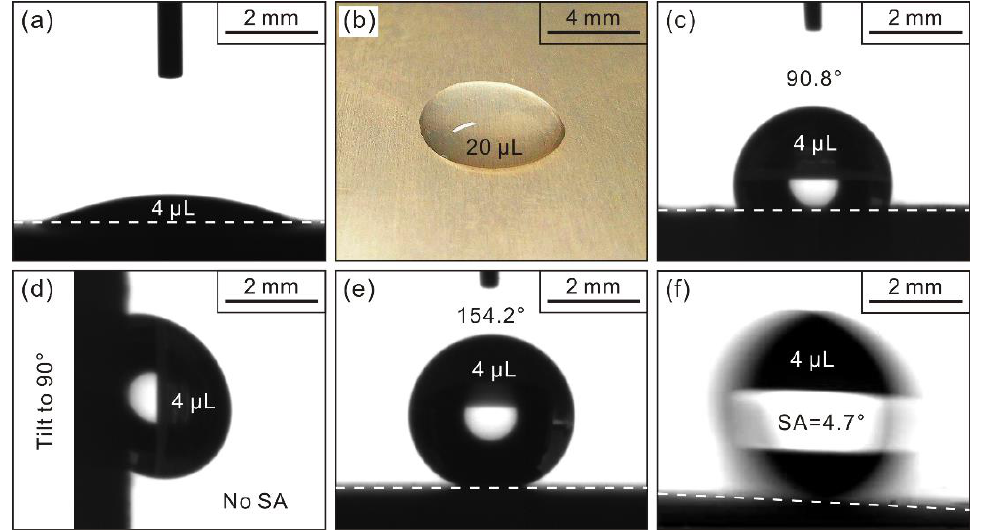
Figure 3. Apparent contact angles of ( a ) Al alloy substrate; ( c ) modified substrate; and ( e ) modified deposited sample; ( b ) o ptical photo of a drop (20 μL) on Al alloy substrate. Sliding angles of ( d ) modified substrate and ( f ) modified deposited sample.